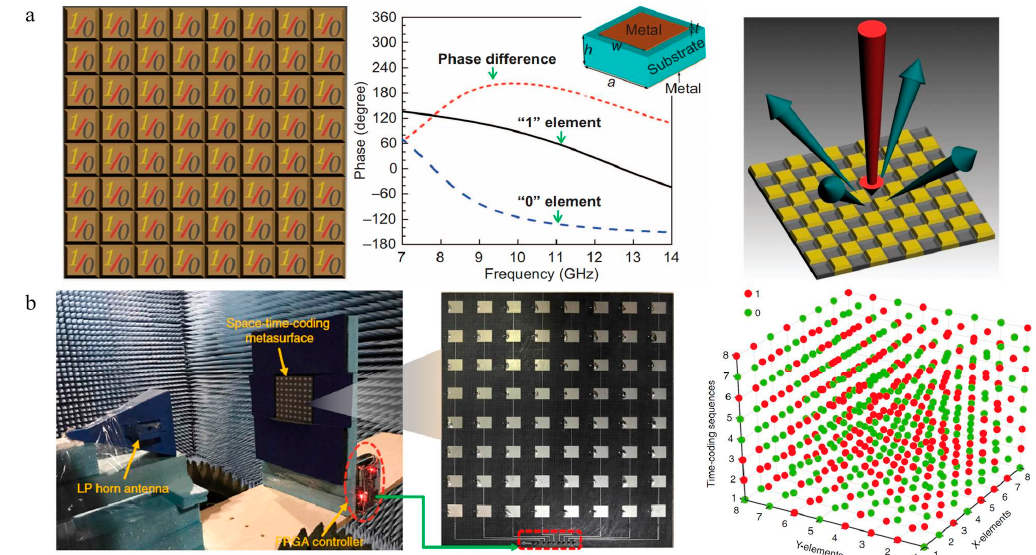
Figure 7. ( a ) A 1-bit digital coding metasurface. Reproduced with permission from [51], Springer Nature, 2018. ( b ) The space-time-coding digital metasurface and 3D coding matrix. Reproduced with permission from [63], copyright Springer Nature, 2018.